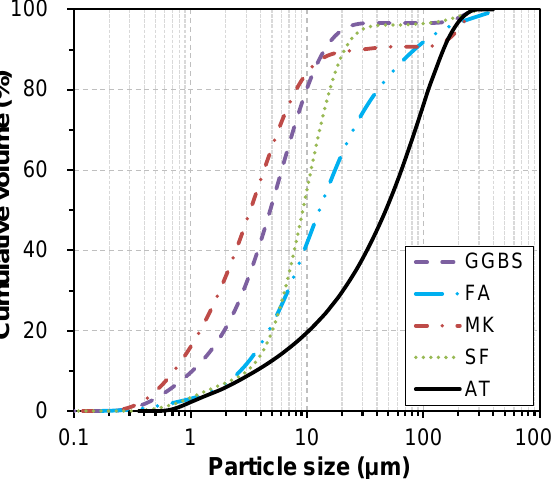
Figure 1. Grain size distribution curves of AT, GGBS, and mineral admixtures. Table 1. Key physical properties of AT, GGBS, and mineral admixtures.